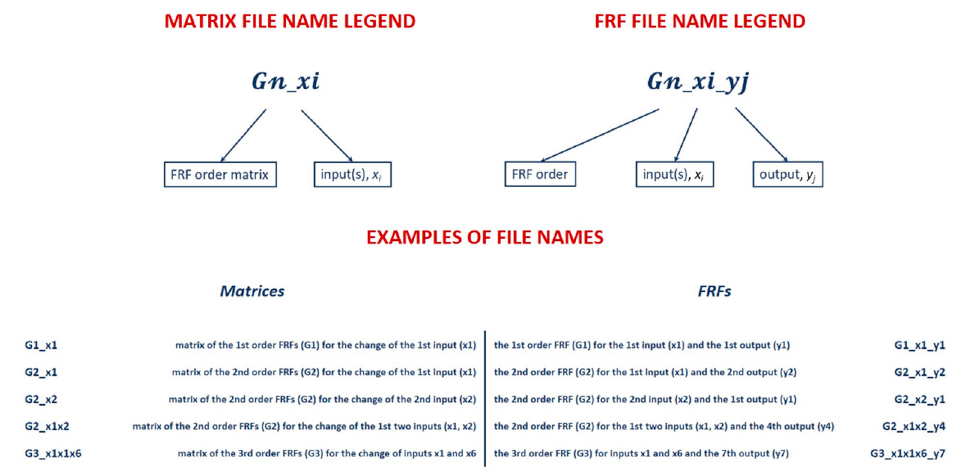
Figure 6. The cNFR Legend Window.